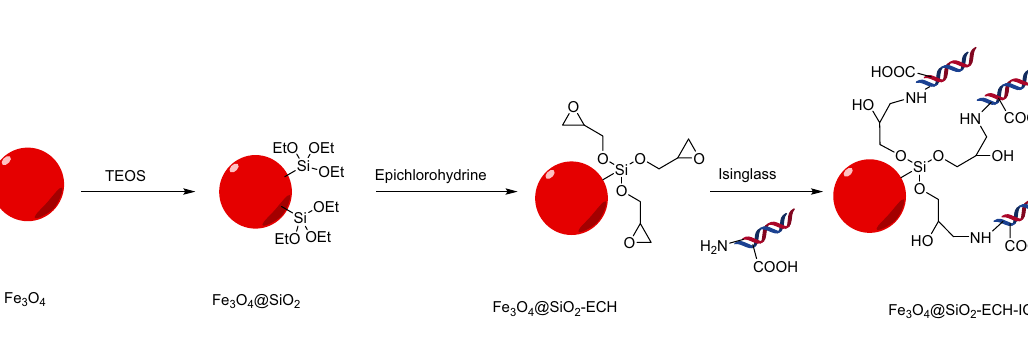
Figure 3. Schematic representation of the catalyst synthesis